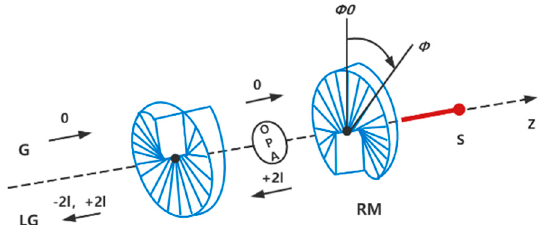
Figure 1. Sketch of a Laguerre–Gaussian cavity composed of two spiral phase elements: the right element represents a fixed mirror and the right one denotes a rotating mirror (MR) rotating around the cavity axis (z axis) which is suspended from a support S. The RM has an equilibrium position of φ 0 = 0 and an angular displacement φ of rotation about the z axis. In addition, the cavity also contains a degenerate OPA. The L–G cavity is driven by an input Gaussian beam. When the Gaussian beam with topological charge 0 is incident upon the L–G cavity, the output field will be added a topological charge 2𝑙 from the mechanical torsional pendulum.